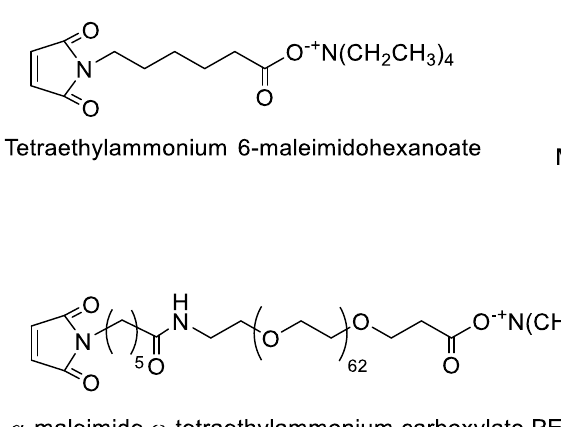
Figure 3. Structure of synthesized initiators.